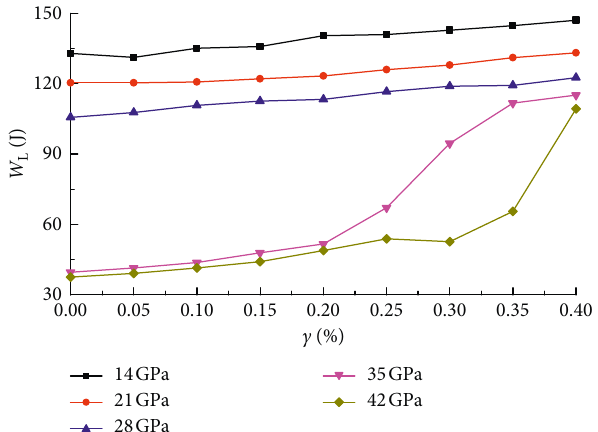
Figure 6: Variation of total absorption energy with end-face nonparallelism.